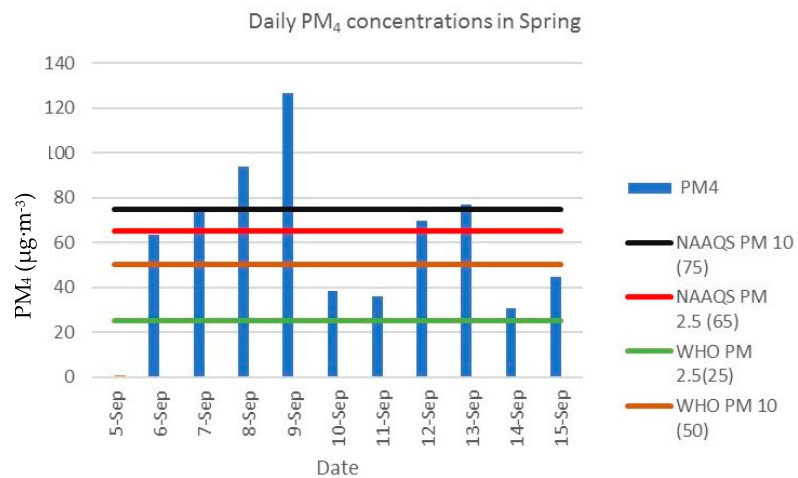
Figure 3. Indoor kitchen PM 4 concentrations measured in spring compared to NAAQS (National Ambient Air Quality Standards) standards and WHO guidelines.